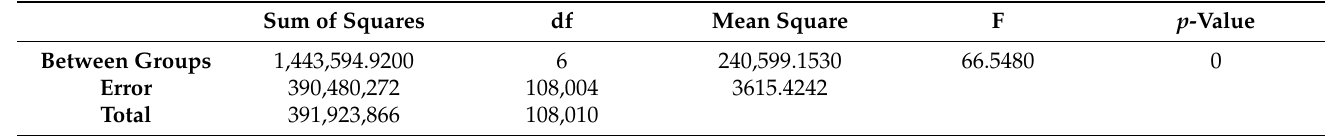
Table A1. ANOVA test results for the seven cities.